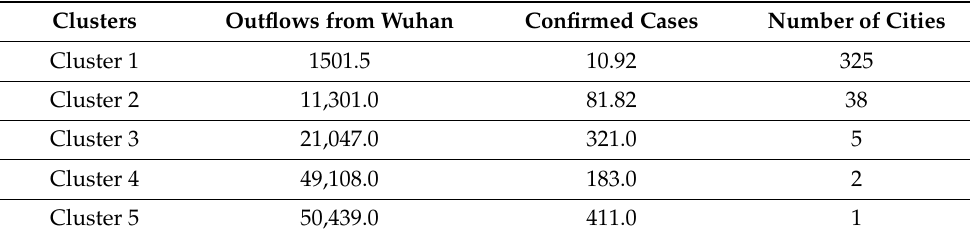
Table 1. The average value of each variable in five clusters.